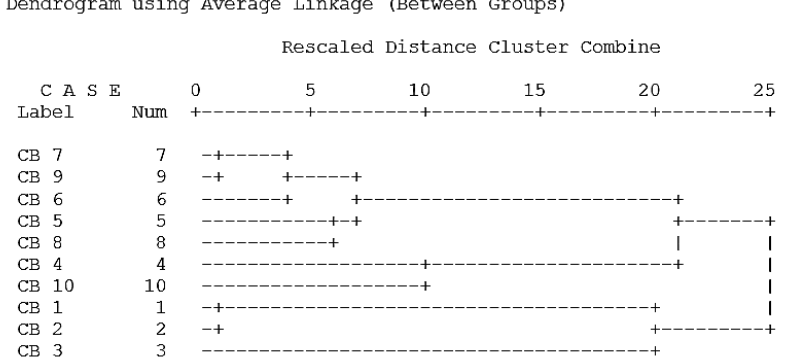
Figure 4. Dendrogram showing the hierarchical clusters of experimental sites of Chalan beel wetland area. Here, Panakora beel (CB 1); Kanar beel (CB 2); Western beel (CB 3); Kawchar beel (CB 4); Khanpara beel (CB 5); Hamkuria beel (CB 6); Mohesh Rohali beel (CB 7); Barohash beel (CB 8); Khuligari beel (CB 9); Udvaria beel (CB 10).